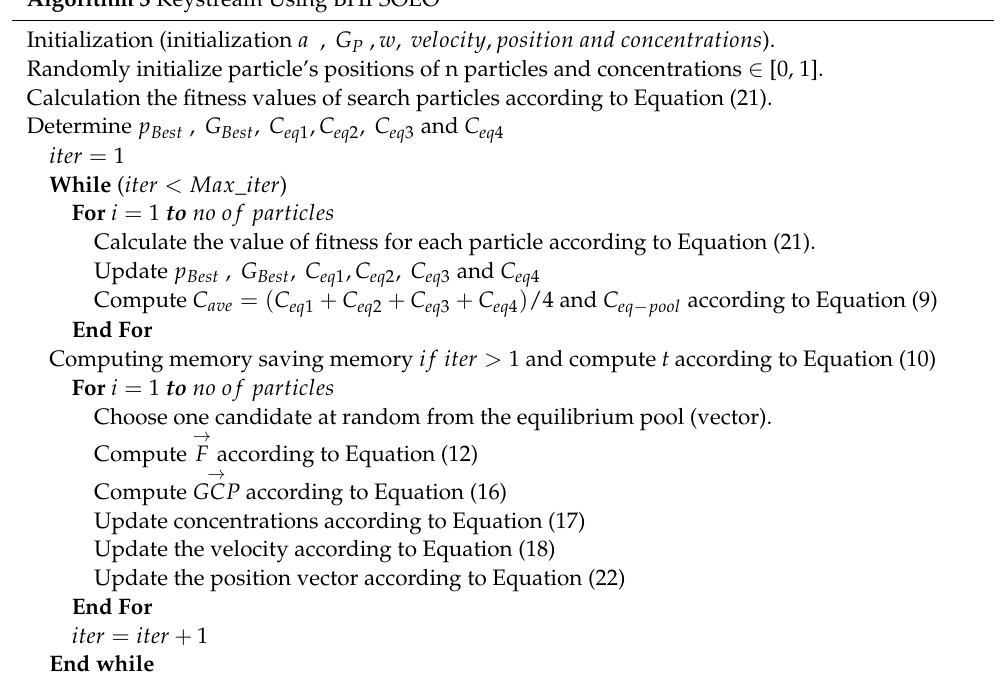
Algorithm 3 Keystream Using